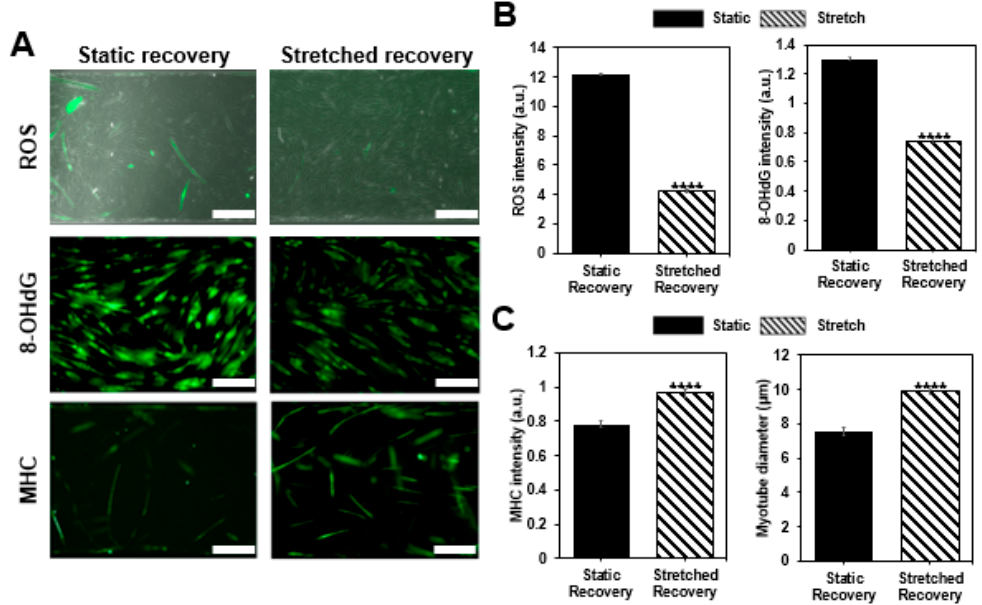
Figure 4. Confirmation of muscle recovery. ( a ) Once muscle cells are damaged by H 2 O 2 , the cells are allowed to recover in the static condition or with the cyclic stretch condition as shown with the merged images of phase contrast and ROS fluorescent image, immunofluorescence image of 8-OHdG, and MHC (scale bar: 200 µ m). ( b ) Analysis of ROS ( n > 54), 8-OHdG ( n > 387), and ( c ) MHC ( n > 172) intensity, as well as a morphological change of myotube by measuring diameter for each group, show the effect of stretch on recovery. Intensity values are normalized to the condition before the damage (all bars represent standard error mean. No star for p ≥ 0.05; * for p < 0.05; ** for p < 0.01; *** for p < 0.001; and **** for p < 0.0001 when tested with Student’s t-test for each